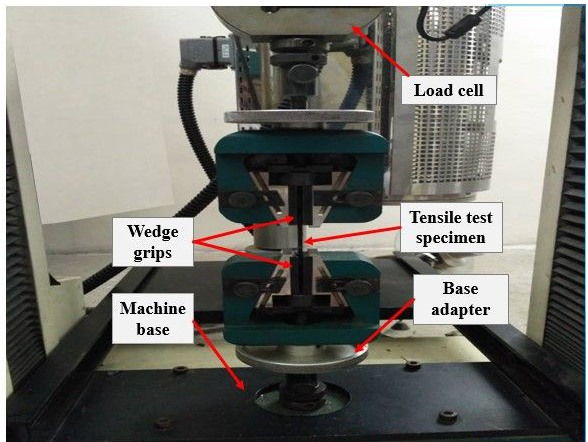
Figure 2: Hounsfield universal testing machine (H25KS) used for tensile